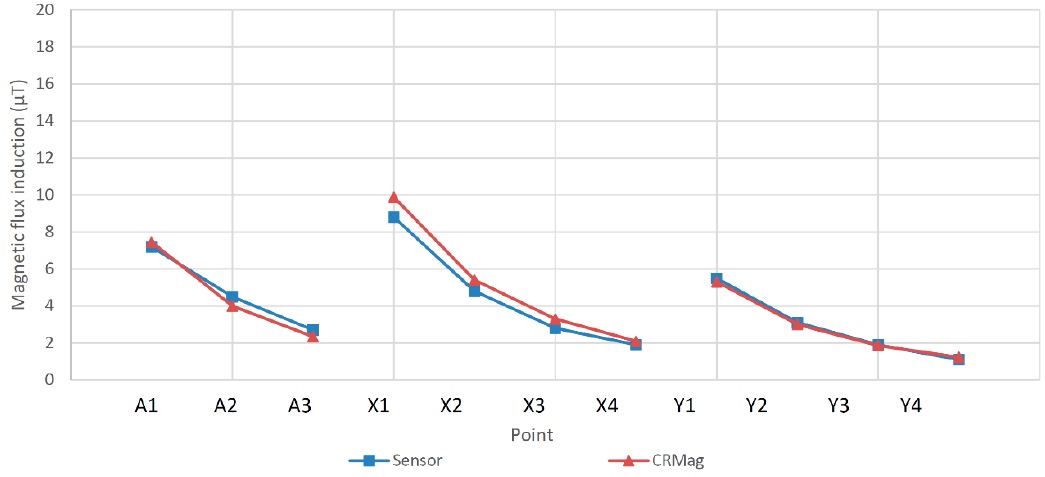
Figure 7. Comparison between the measured and calculated magnetic flux density (MFD) around the distribution transformer.